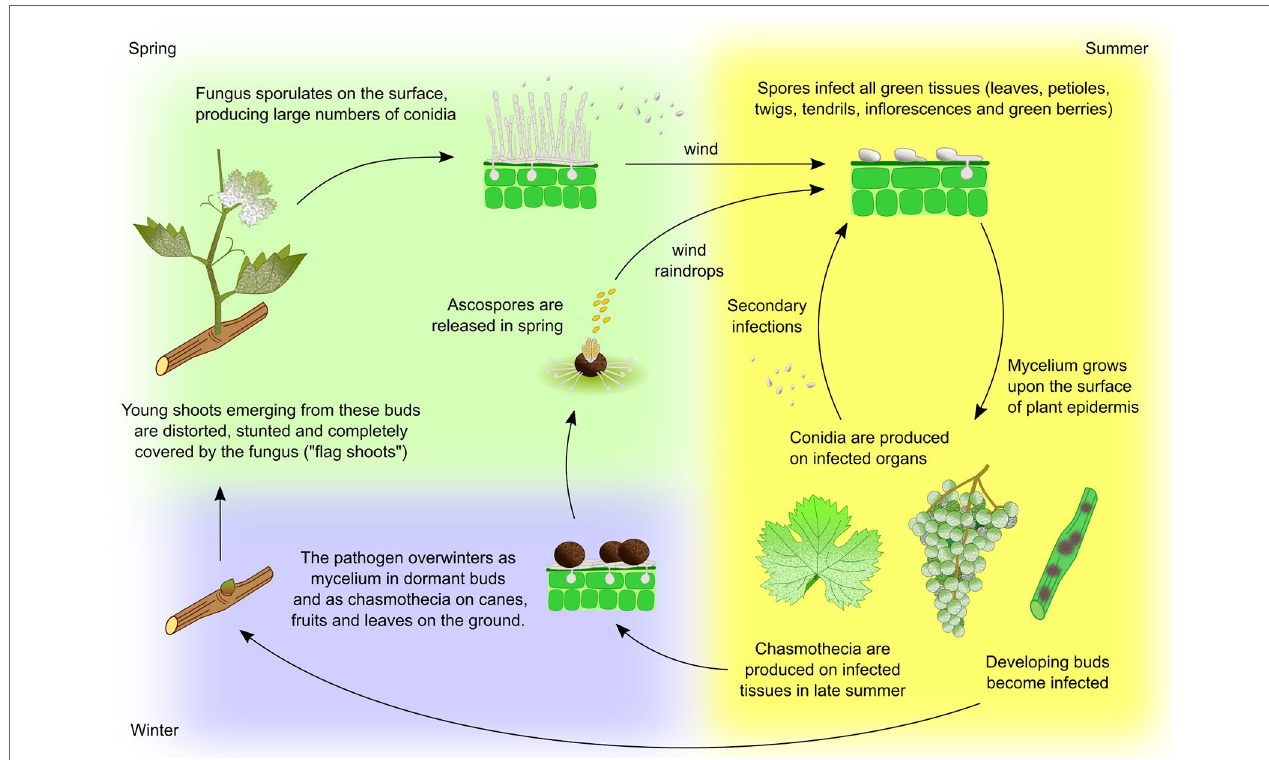
FIGURE 2 | Erysiphe necator life cycle. Two overwintering strategies have been observed in E. necator . In areas with relatively mild winters, the fungus commonly overwinters as mycelium on leaf primordia within dormant buds. In the following spring mycelium activity resumes, resulting in the production of heavily infected and deformed shoots, called ‘flag shoots’. The fungus sporulates on these shoots, producing a large number of conidia that are carried by the wind to healthy plant tissues. Alternatively, the fungus can overwinter as chasmothecium (syn. cleistothecium, a former term for this structure that is still widely used) in bark, on canes, leftover fruit, and on leaves on the ground. Chasmothecia form on the surface of heavily diseased tissues from mid-summer to autumn. During spring rainfall the chasmothecia open and release ascospores, which are spread by wind or raindrops to infect the lower leaves near where the chasmothecia have overwintered. Although free water is necessary to release ascospores, continued wetness is not required for subsequent spore germination and infection. At each new infection site, conidia and ascospores germinate and form an appressorium. From its lower surface a penetration peg develops, piercing the cuticle and entering through an epidermal cell where a haustorium is formed. Mycelium grows upon the surface of the plant epidermis and new conidia are produced within a few days, completing the cycle. Repetition of this cycle continues throughout the growing season resulting in a rapid increase in disease incidence (Wilcox et al., 2017).